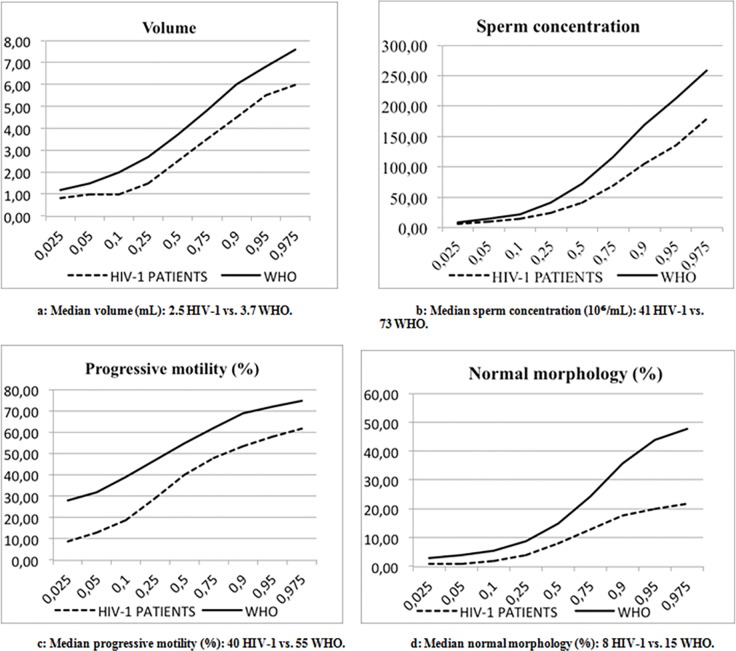
Distribution of semen parameters based on percentiles in the total study population and the WHO reference group.Semen parameters of HIV-1 infected men, including median volume (a), sperm concentration (b), progressive motility (c), normal morphology (d) and total sperm count were significantly decreased compared to the WHO distribution.